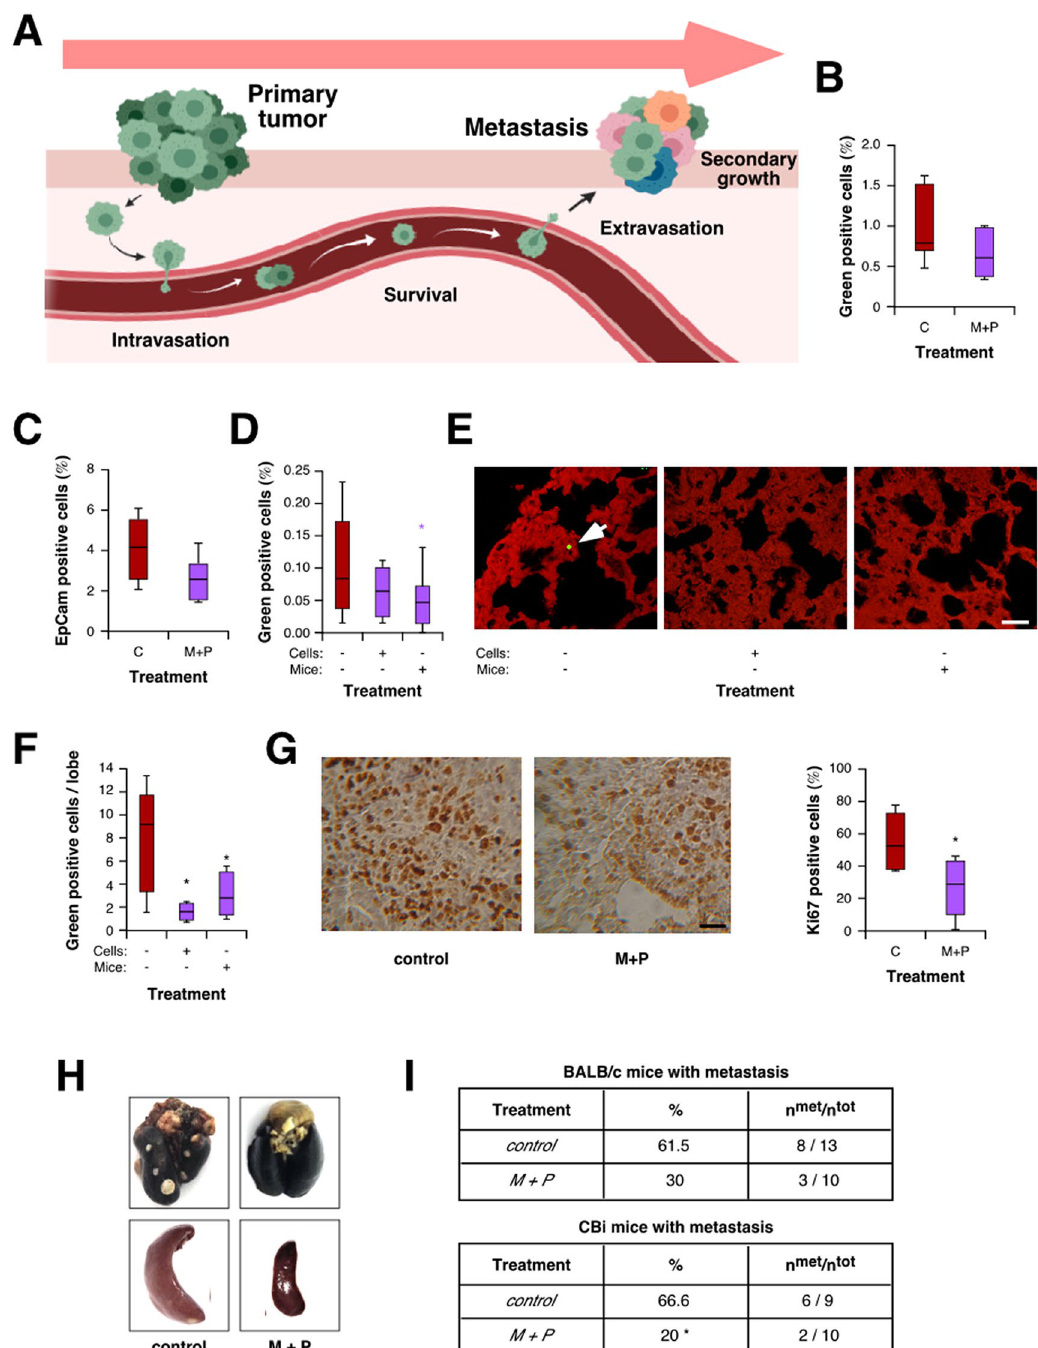
Figure 4. M + P combination prevents secondary tumor growth by affecting different steps leading to metastasis. ( A ) Scheme of the different steps involved in metastasis development analyzed in this section. ( B , C ) Intravasation was estimated by flow cytometry quantification of green-positive cells in the bloodstream after orthotopical injection of 4T1-GFP cells ( B ) and flow cytometry quantification of EpCam + CD45 − CD34 − cells present in blood after orthotopical injection of 4T1 cells ( C ; p = 0.066). ( D ) Cell tracker stained 4T1 cells were i.v. injected and survival was estimated 48 h later by flow cytometry as described in Material and Methods. ( E , F ) Representative pictures ( E , scale bar = 100 µm) and quantification ( F ) of green positive cells in the lung parenchyma. ( G ) Proliferation of cells in secondary nodes was evaluated and quantified by Ki67 immunostaining of lung metastasis (scale bar = 100 µm). ( H , I ) BALB/c and CBi mice were orthotopically injected with 4T1 ( H and I , top panel) or M-406 ( I , bottom panel) cells, respectively. Tumors were surgically removed. M + P was added to the drinking water of treated animals. At the end of the experiment lungs and spleen were collected ( H ) and observed for the presence of metastasis ( I